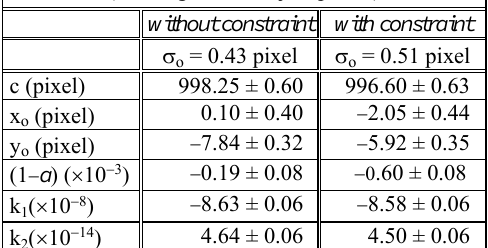
Table 1. Calibration results for image set 1